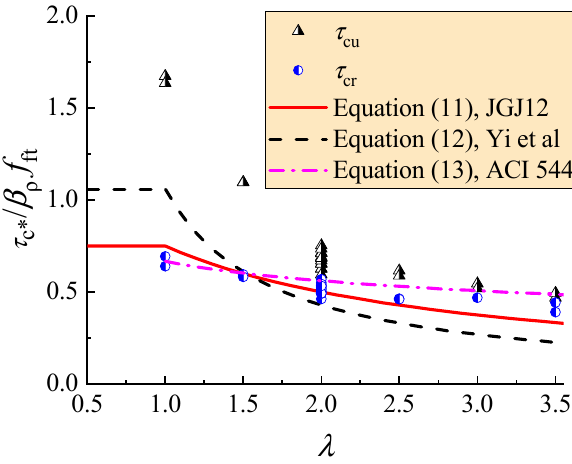
Figure 15. The comparison of predicted results to test data.